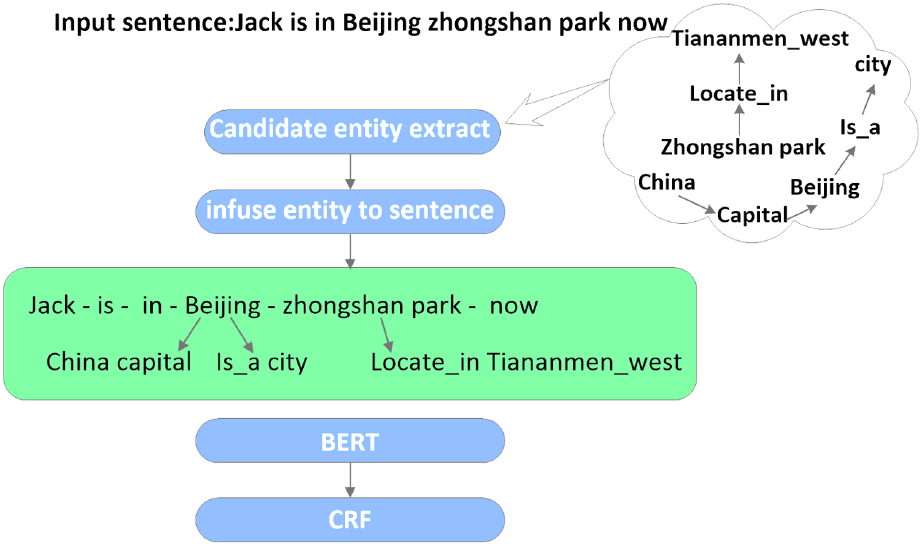
Figure 1. The model